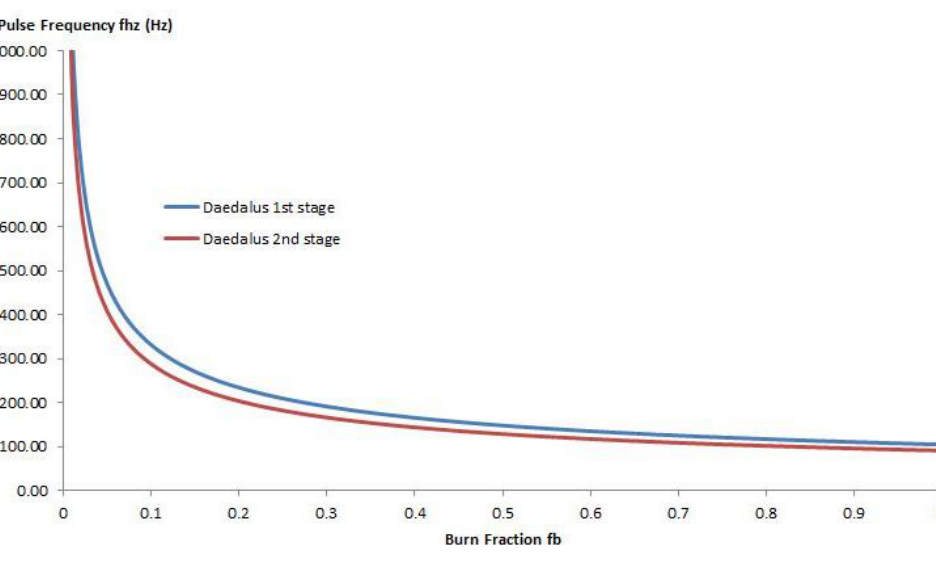
Figure 6. Propulsion pulse frequency as a function of capsule burn fraction performance for an assumed constant thrust and capsule